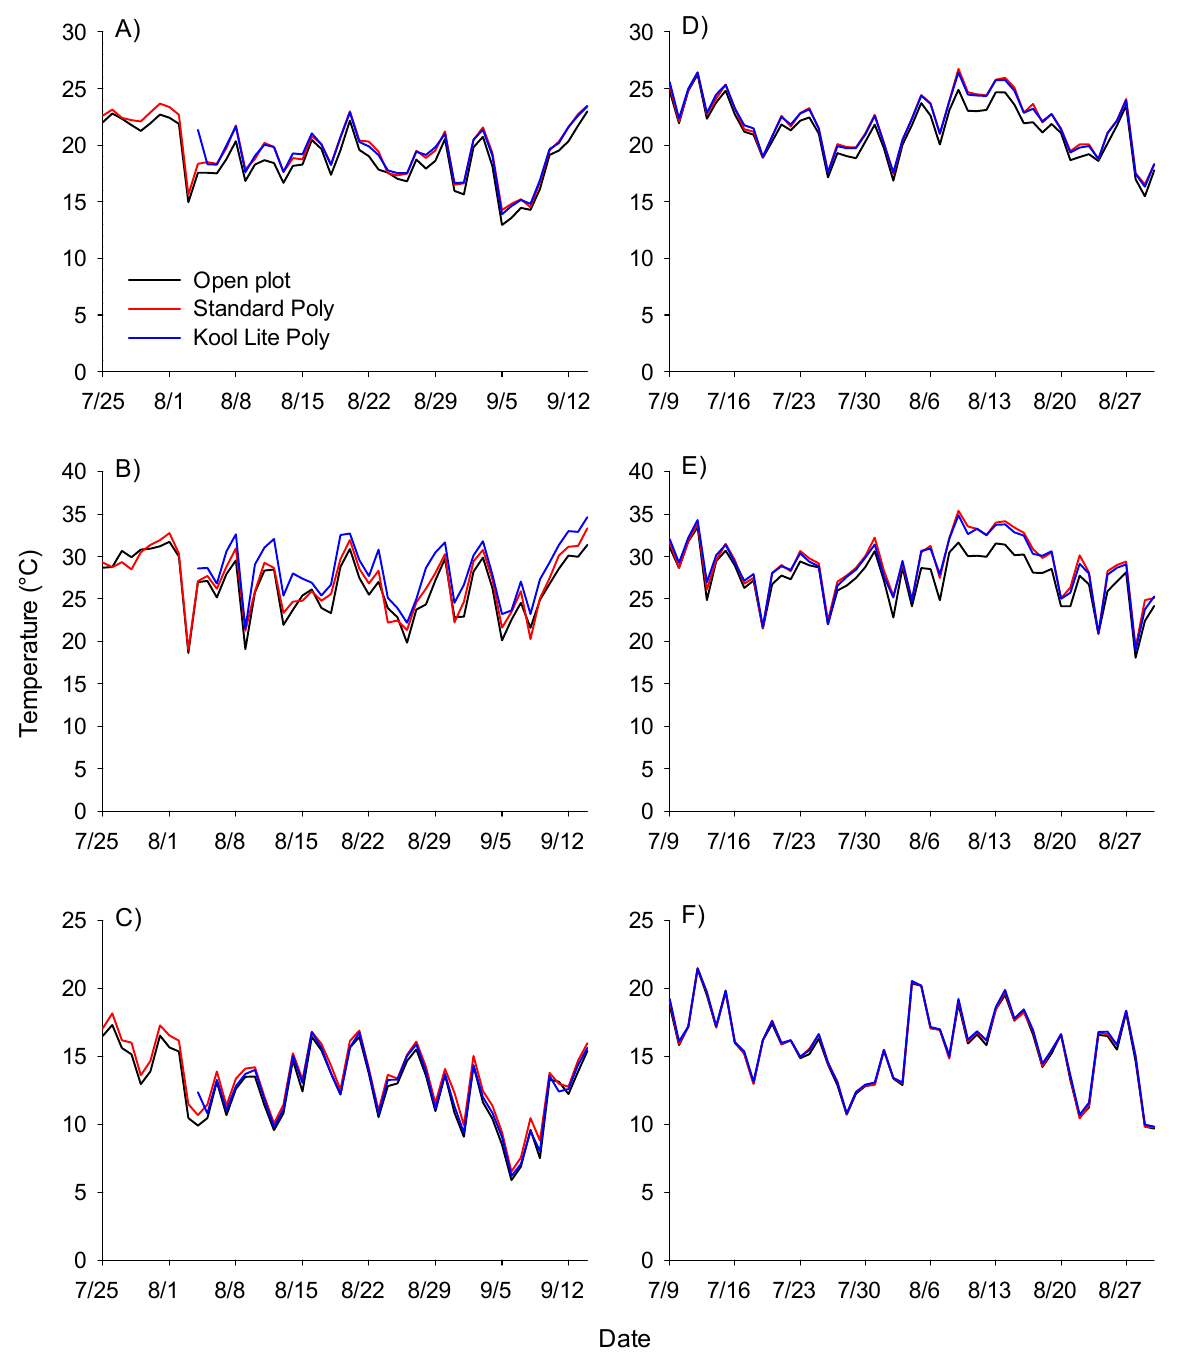
Figure 3. Temperature summary for various high tunnel treatments. Open plots are indicated with a black line, standard poly with a red line and Kool Lite poly with a blue line. Three replicates of temperature data were recorded with Hobo temperature data recorders and are summarized as mean average daily temperature in 2017 ( A ) and 2018 ( D ), mean maximum daily temperature in 2017 ( B ) and 2018 ( E ), and mean minimum daily temperature in 2017 ( C ) and 2018 ( F ).